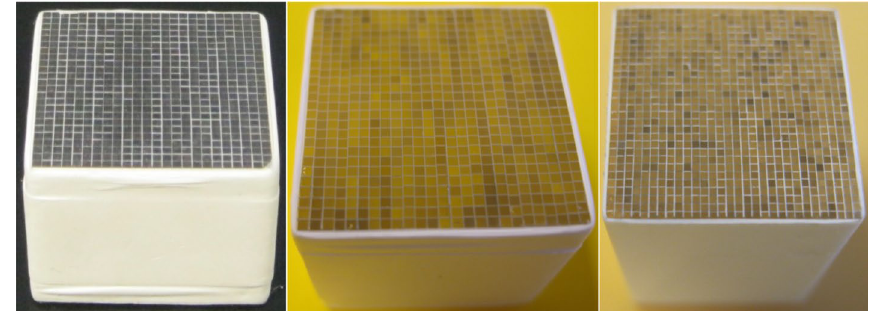
Fig. 6 LYSO arrays with different pitch sizes. (left) 1.0 mm pitch size, (middle) 0.75 mm pitch size, and (right) 0.5 mm pitch size [52, 128,